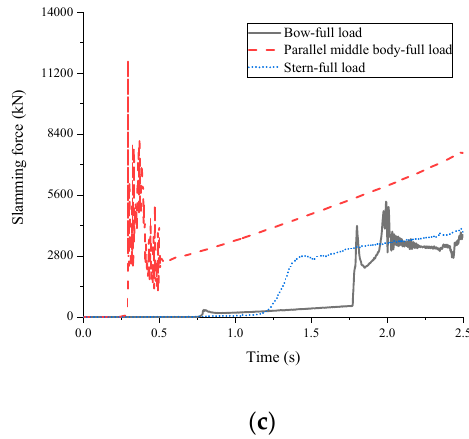
Figure 27. Slamming force of each section at different loading conditions: ( a ) Lightship weight; ( b ) half load; ( c ) full load. Table 7. The peak value of the slamming forces of different sections under each different loading condition.